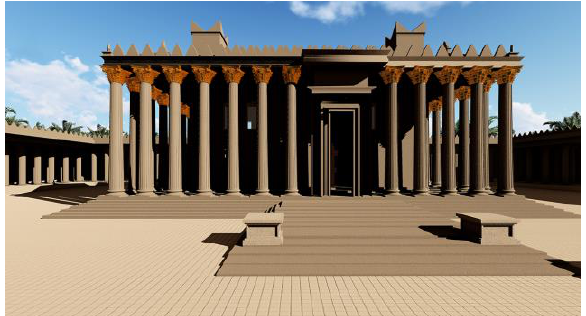
Figure 5.Columns of peristyle were topped with bronze gilded capitals that meant tons of